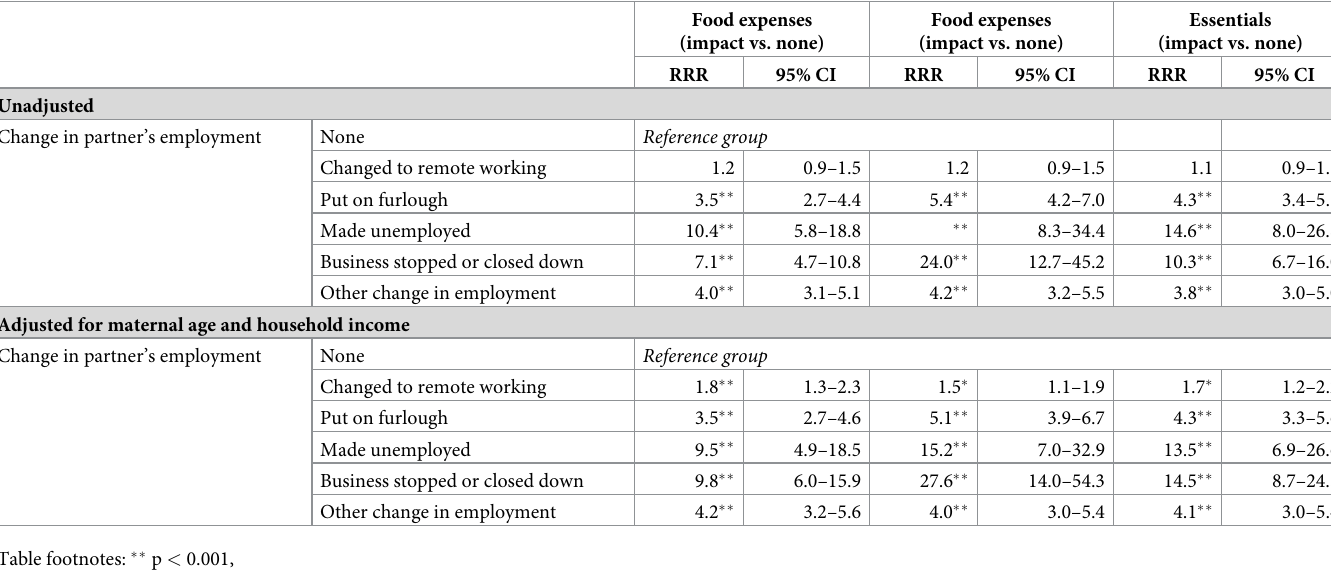
Table 5. Regression of partner’s change in employment and impact on expenses during the COVID-19 pandemic, UK COVID-19 New Mum Study (28 th May 2020- 26 th June 2021, N = 3232).